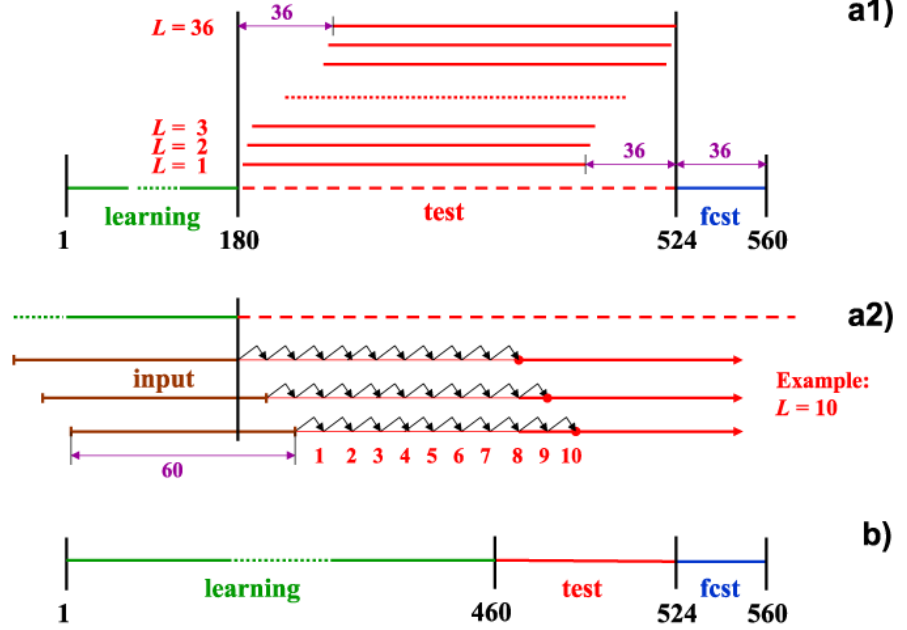
Fig. 3. Schematic diagram of the learning (green), testing (red) and forecasting (blue) sections. The numbers in black indicate the boundaries of the three sections, in number of samples, while the numbers in purple indicate lengths. The length of the forecasting section is L max =36 samples. (a1) Here, the learning section has length N learn =180 samples and the test section has a total length of N test =344 samples; the tests are carried out over a sliding window whose length K is fixed, K =308 samples, and whose position shifts ahead as the lead increases (red segments). The sliding window provides K pairs of predicted − true values for computing the root-mean-square (rms) forecast errors R(L) at every lead time { L : 1 ≤ L ≤ L max =36 } ; see text for details. (a2) Example of iterative one-step-into-the-future forecast producing the first three samples of the sliding window in the position that corresponds to lead L =10 samples. Input true samples are represented by brown segments. (b) An alternative approach with a longer learning section of N learn =460 samples, a shorter test section of N test =64 samples, and no sliding window. In this case, the rms error is evaluated globally over all